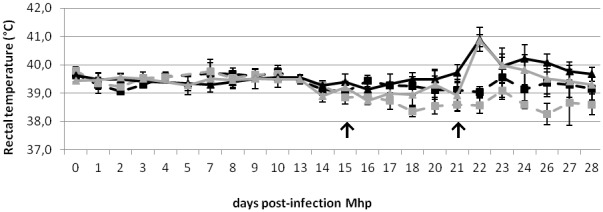
Mean rectal temperatures (°C) of pigs.Mean rectal temperatures in co-infected (MH1N1) and control (C) pigs fed ad libitum (AL) or feed restricted (FR) : C-AL (black dashed line), C-FR (gray dashed line), MH1N1-AL (black solid line) and MH1N1-FR groups (gray solid line), from the day of Mhp inoculation (day 0) until the end of the experiment. Arrows indicate the day of the beginning of the feed restriction (day 15) and the day of H1N1 inoculation (day 21).